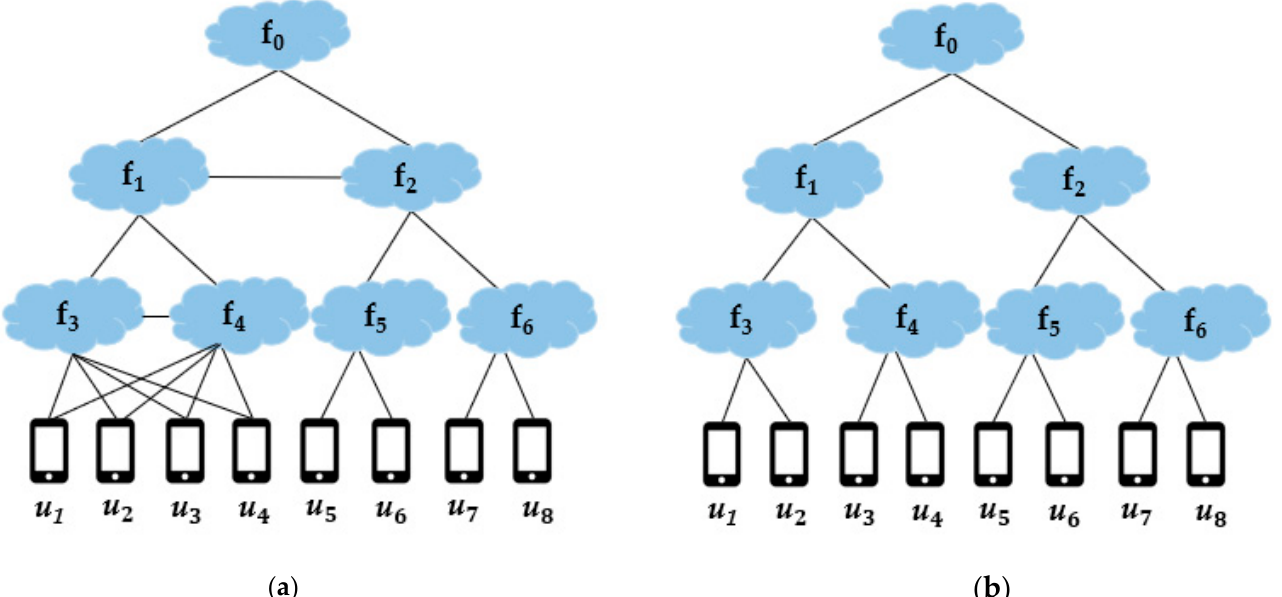
Figure 1. Logical fog network: ( a ) an example of a physical network; ( b ) the logical fog network of ( a ).